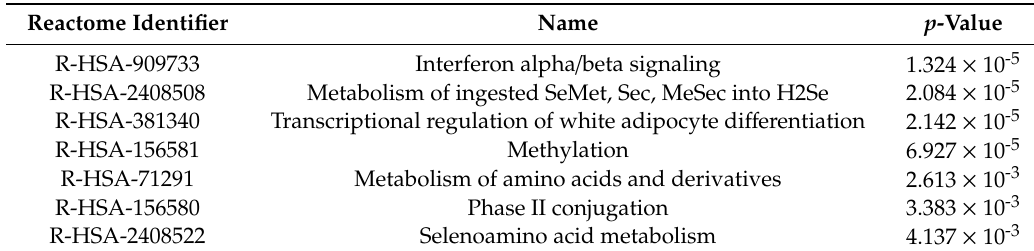
Table 2. Pathway ontologies of upregulated genes in relapsed, drug treated BL0293 and BL0440 PDX tumors using ToppGene ToppFun